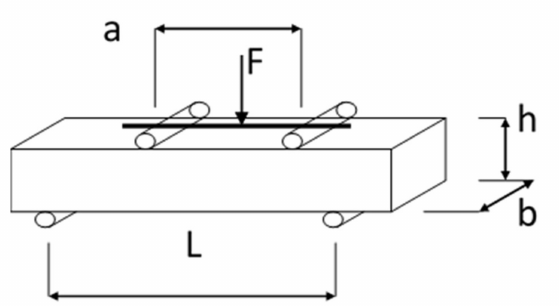
Figure 2. Beam-Flex apparatus.